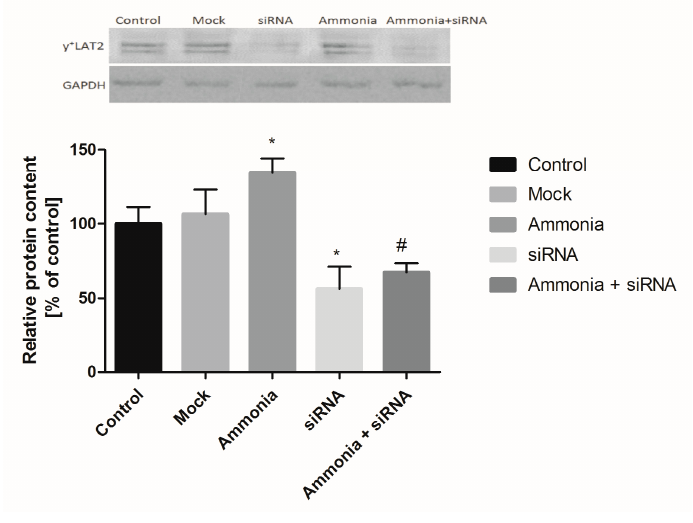
Figure 1. The effect of silencing of the Slc7a6 gene on y + LAT2 protein level in astrocytes in relation to glyceraldehyde-3-phosphate dehydrogenase (GAPDH) protein level. Upper panel shows representative Western blots. Results are mean ± SD; n = 4, * p < 0.05 vs. control; # p < 0.05 vs. ammonia. The effect of ammonia treatment and Slc7a6 gene silencing in primary cultured astrocytes obtained by high-performance liquid chromatography (HPLC) is shown in Table 1. Incubation with 5 mM ammonia reduced both ADMA (by ~38%) and SDMA (by ~44%) without significantly changing Arg level. Silencing of Slc7a6 gene prevented ammonia-induced intracellular ADMA and SDMA reduction in astrocytes, indicating that y + LAT2 mediates transmembrane transport of dimethylarginines in these cells.